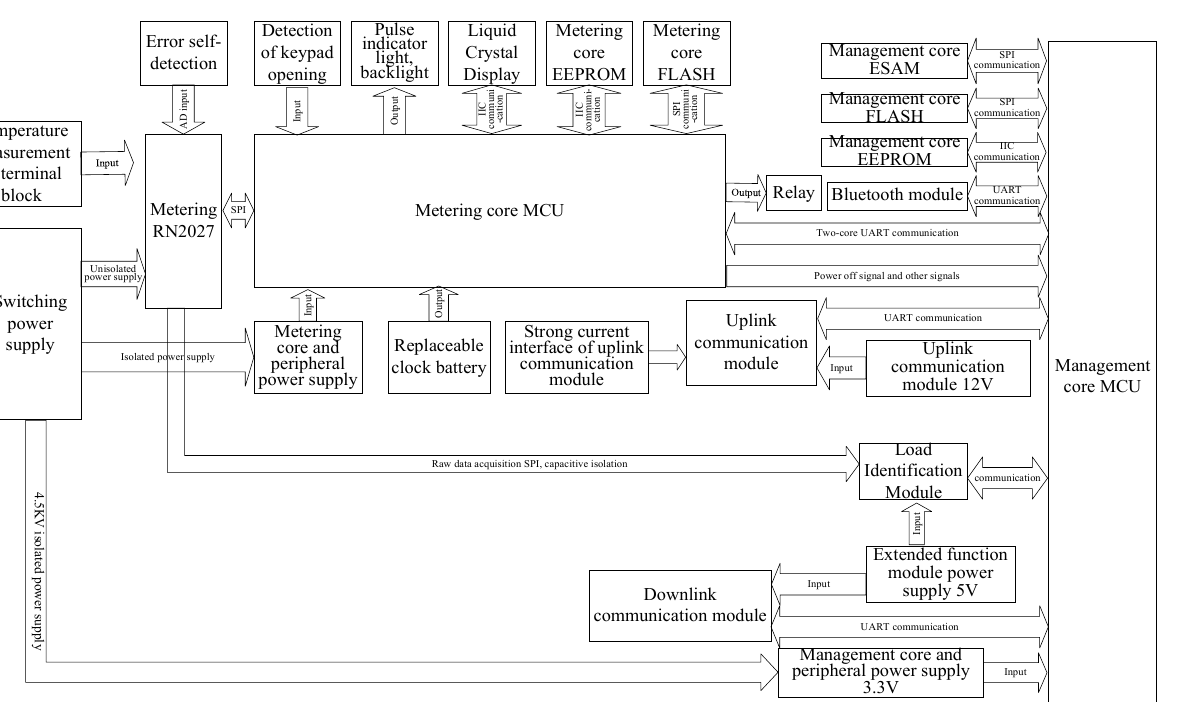
Figure 2. Block diagram of a smart meter system.